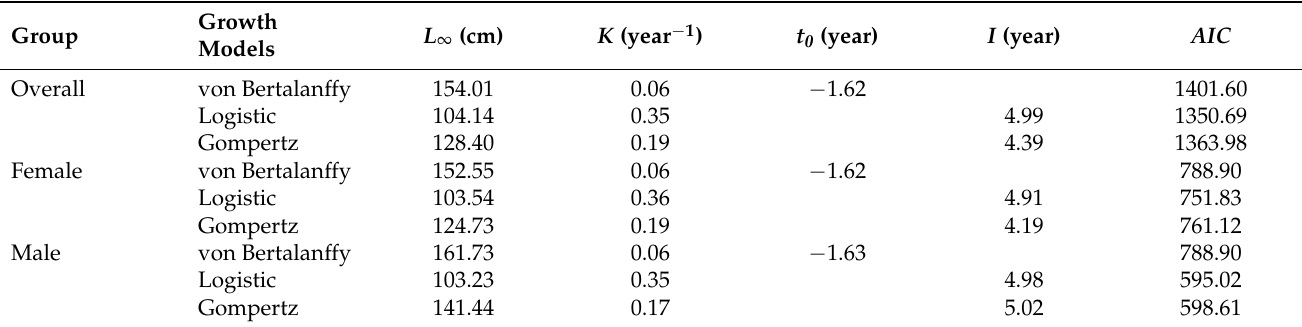
Table 3. The growth parameters for Dipturus oxyrinchus inhabiting the Northeastern Mediterranean Sea derived from different growth models.